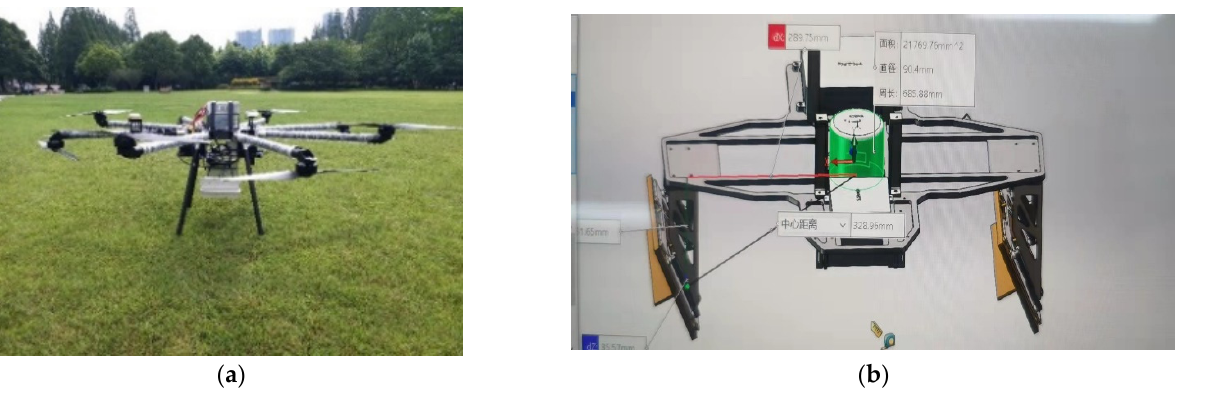
Figure 4. Illustration of the UAV-borne PolInSAR. ( a ) Photo of the system. ( b ) Structure of the system; and the explanations of the Chinese are: The distance between POS and one antenna in a horizontal direction dx is 289.75 mm. The distance between POS and one antenna is 328.96 mm. The area of the POS is 21,769.76 mm 2 , the diameter is 90.4 mm, and the perimeter is 685.88